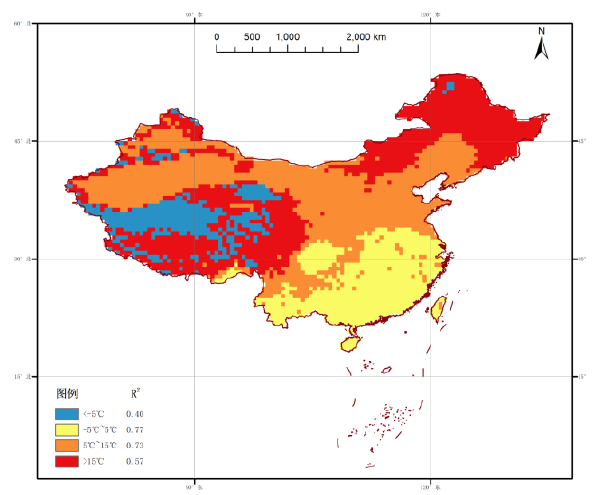
Figure 1. The relationship between SIF and GPP is analysed in four levels of annual average temperature used simple linear regression analysis.